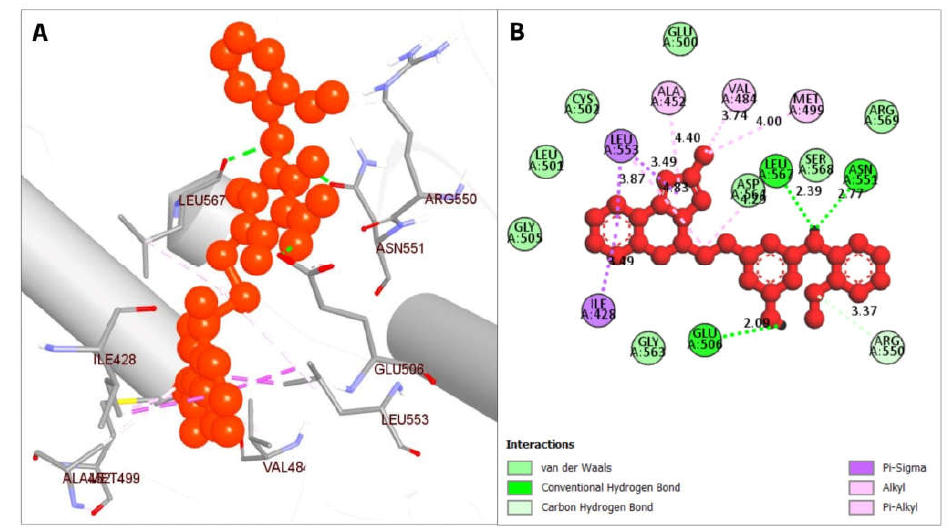
Figure 4. The non-bonded interaction of the CID24601203 and main protease from FAK1 at certain simulation times. Herein, ( A ) representing the 3D protein-ligand interaction and ( B ) representing 2D interaction of the protein with the ligand.